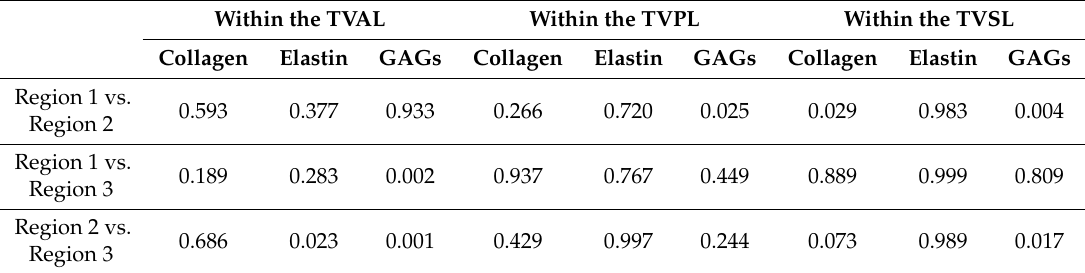
Table 3. Statistical comparisons ( p -values) of the constituent mass fractions, between any two regions within each of the three representative heart #1 TV leaflets (see Figure 1d).